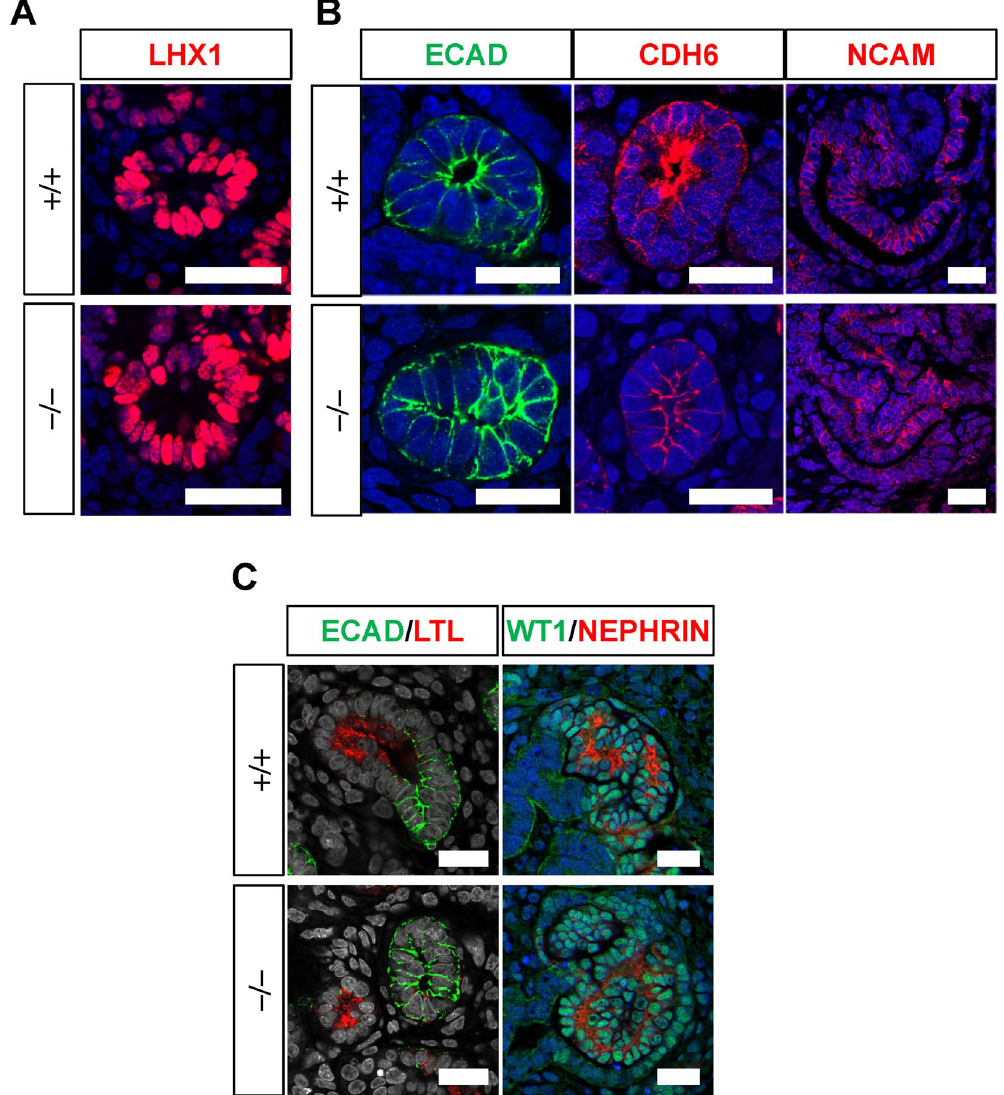
Figure 4. Sorted PAX2 -null human nephron progenitors undergo mesenchymal-to-epithelial transition. ( A ) LHX1 + renal vesicles are induced from both the wild-type and PAX2-null nephron progenitors at day 3 of co-culture with spinal cord. ( B ) E-CADHERIN (ECAD) + distal and CADHERIN6 (CDH6) + proximal renal tubules, as well as NCAM + S-shaped bodies, are formed from the wild-type and PAX2 -null nephron progenitors at day 6. ( C ) Renal tubules and glomeruli are formed at day 9. Left panels: ECAD + distal and LTL + proximal renal tubules; right panels: WT1/NEPHRIN + glomeruli. Scale bars: 25 µ